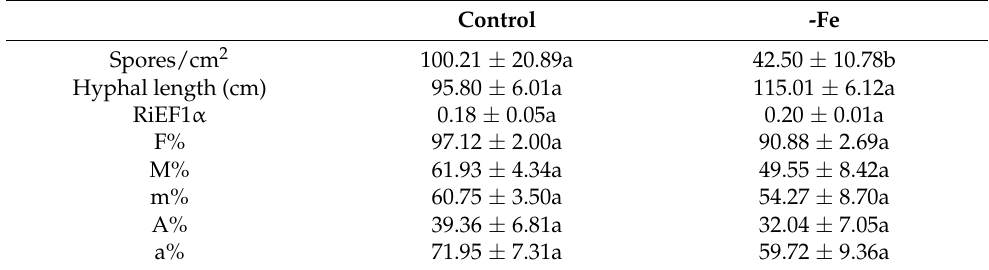
Table 2. Effect of Fe deficiency on ERM development and mycorrhizal